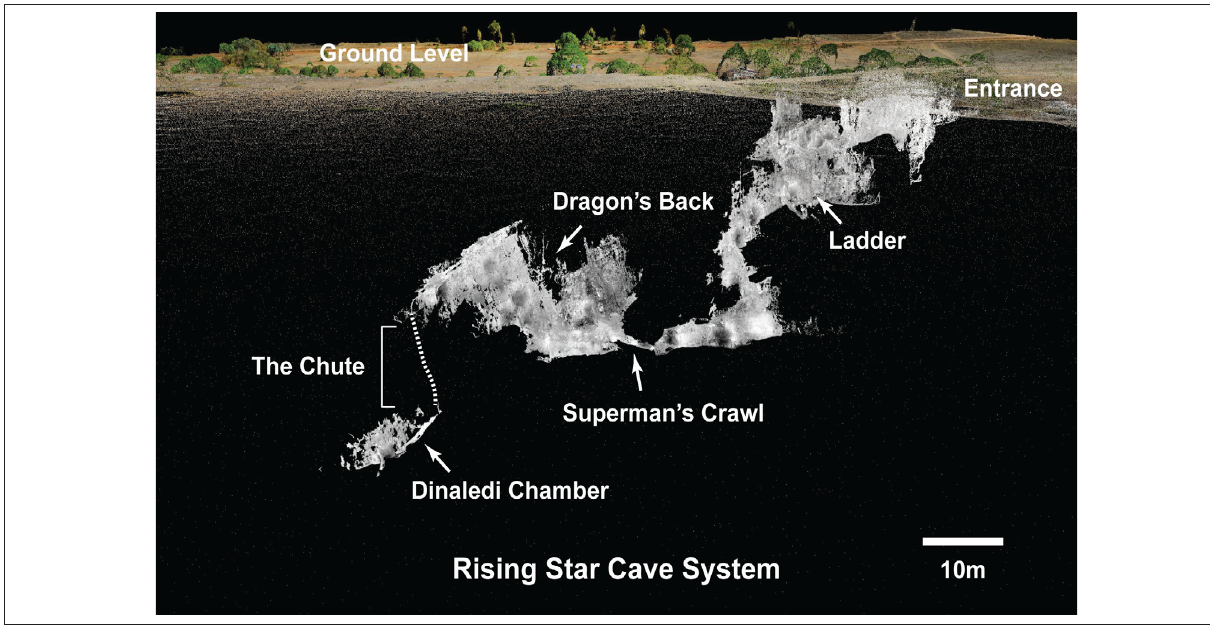
Figure 9: Point cloud data generated from an amalgamation of three-dimensional data collection techniques including unmanned aerial vehicle photogram- metry, high-resolution laser scans and the laser distance meter, showing the accurate position of the Rising Star Cave, including the position of the Dinaledi Chamber, in relation to the above ground level. Scale bar indicates both horizontal and vertical